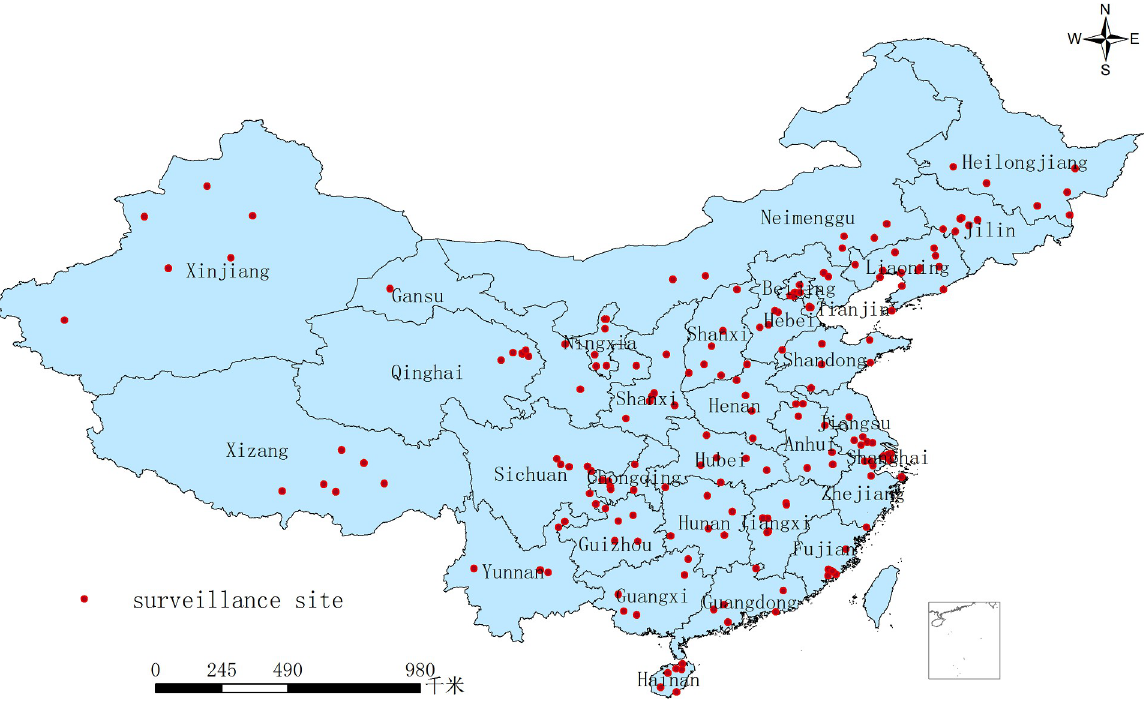
Fig 1. 200 surveillance sites for hepatitis B in China. Fig 1 represents 200 surveillance sites for hepatitis B in China. Each province has a hepatitis B surveillance site. A red dot represents a surveillance county.